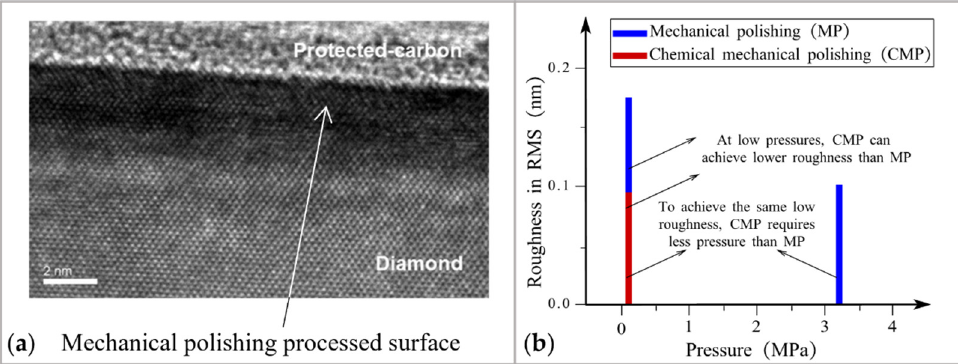
Figure 8. The effect of pressure on SCD roughness: ( a ) Cross-sectional transmission electron microscopy image of the polished diamond surface. Reproduced with permission from [83]; ( b ) The roughness achieved in mechanical and CMP at different pressure.